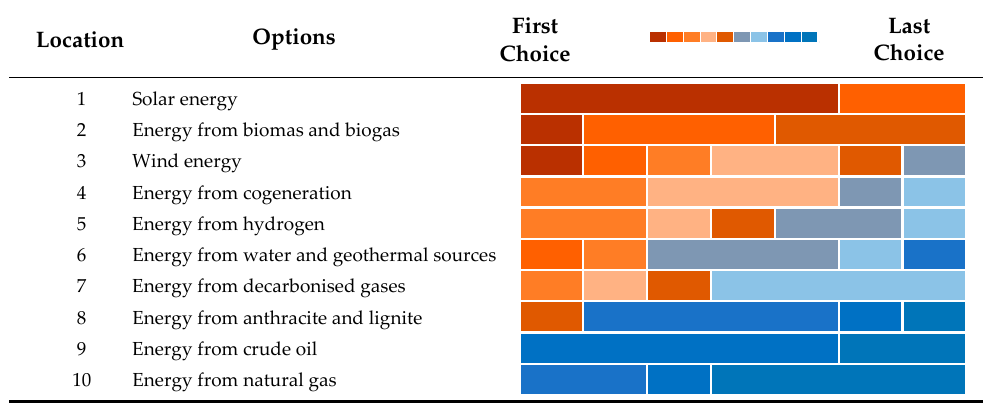
Table 4. Development of energy sources in Eastern Poland resulting from potential growth deter- minants of the macroregion.